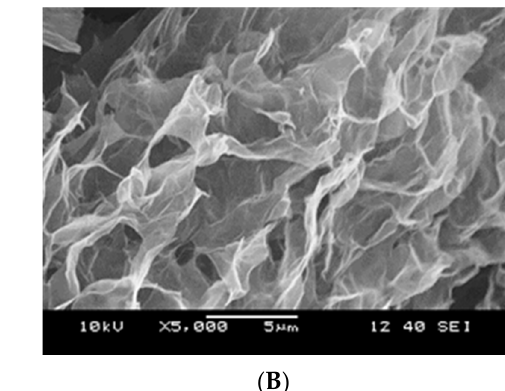
Figure 9. Proposed mechanism for microstructural changes of GO suspensions upon shearing and relaxation. Black lines represent GO platelets, pink areas strongly functionalized regions with high oxygen content, dark blue is bound water, light blue shows the bulk aqueous phase.